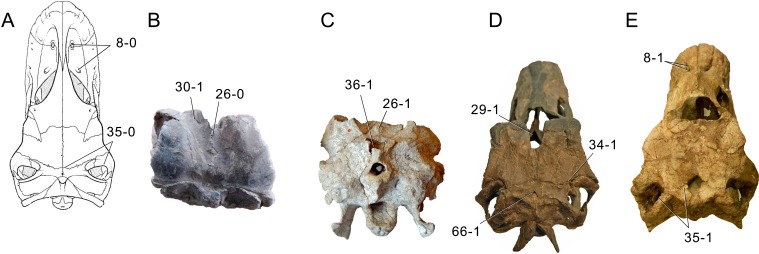
Sauropod skulls.Skulls of Camarasaurus (A; modified from Wilson & Sereno, 1998), Limaysaurus tessonei MUCPv-205 (B; photo by J Whitlock), Dicraeosaurus hansemanni MB.R.2379 (C) Kaatedocus siberi SMA 0004 (D) and Diplodocus sp. CM 11161 (E) in dorsal view, illustrating the states of the characters 8, 26, 29, 30, 34, 35, 36, 66. Not to scale.